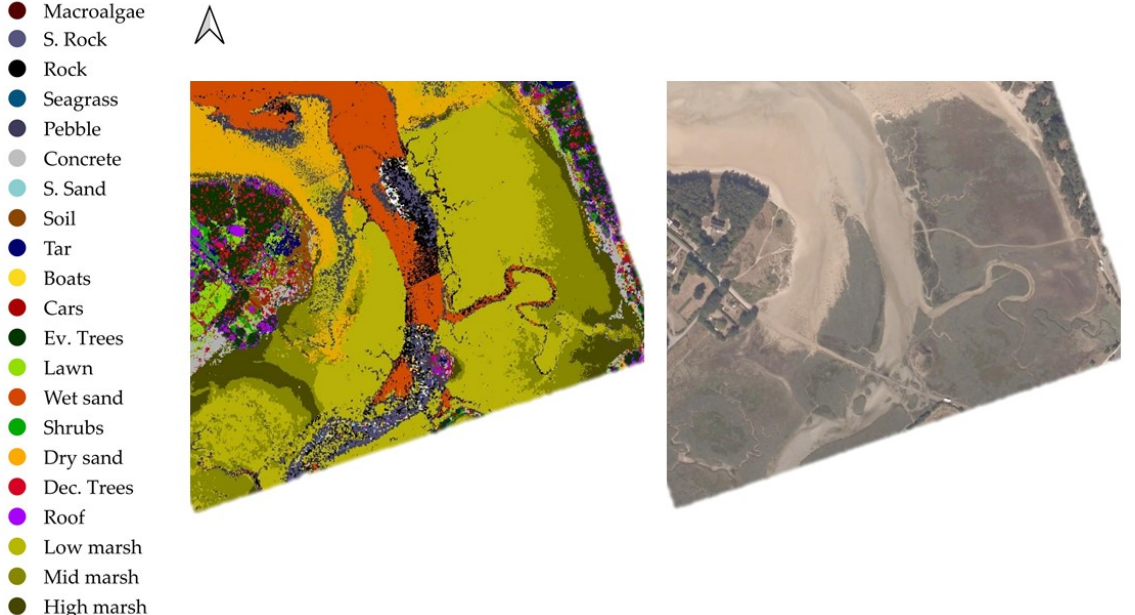
Figure 11. Salt marsh classification: Extract of the projected 3D map of the habitats obtained with the predictions of a random forest classifier on green spectral features, infrared intensities, and elevation values, and extract of an orthoimage of the same area. The orthoimage was captured in 2014, while lidar data are not contemporaneous as they date from 2019. S. = submerged, Ev. = evergreen, Dec. =